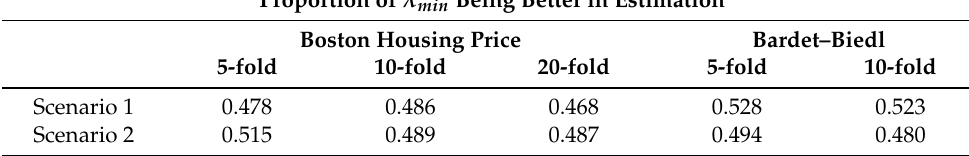
Table 4. Regression estimation